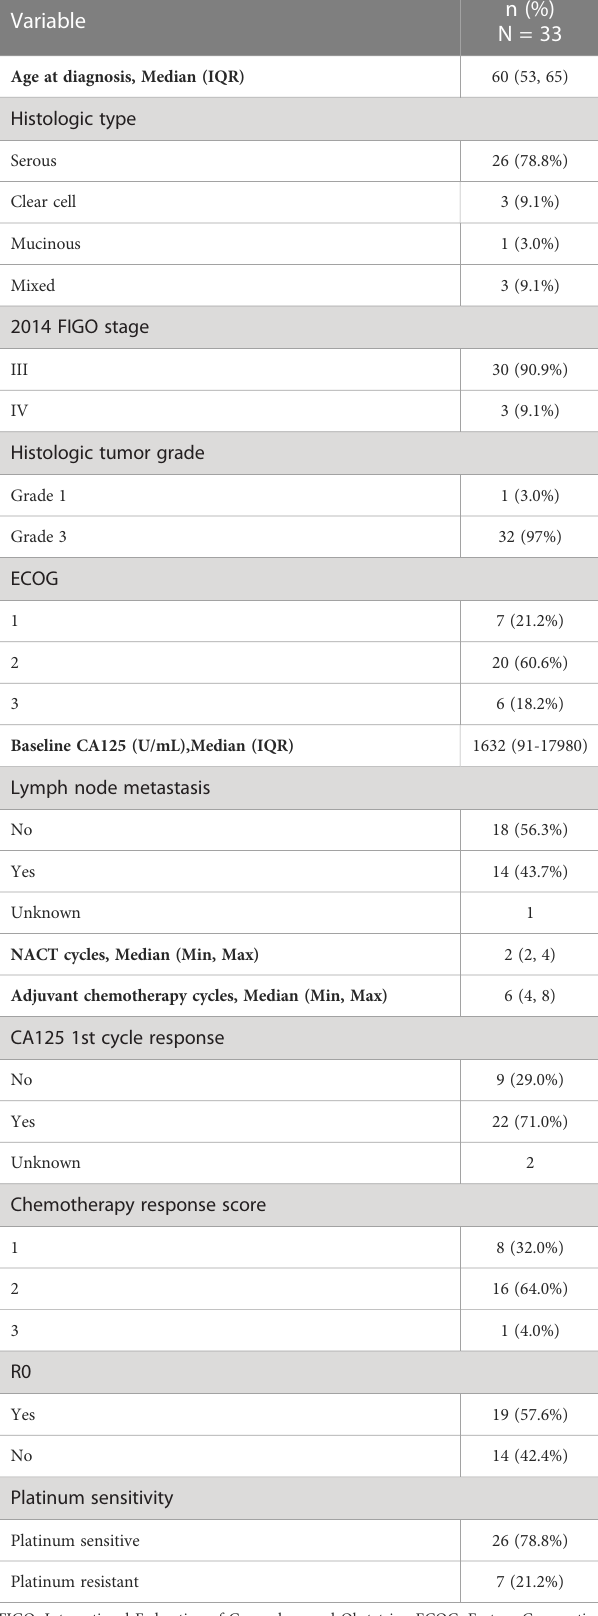
TABLE 1 Clinicopathological characteristics of patients (n=33).